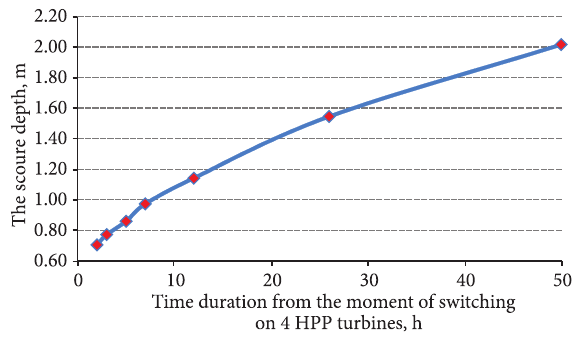
Fig. 11. Dynamics of the bridge abutment scour depth in Kaunas HPP after switching on 4 turbines ( d = 0.2